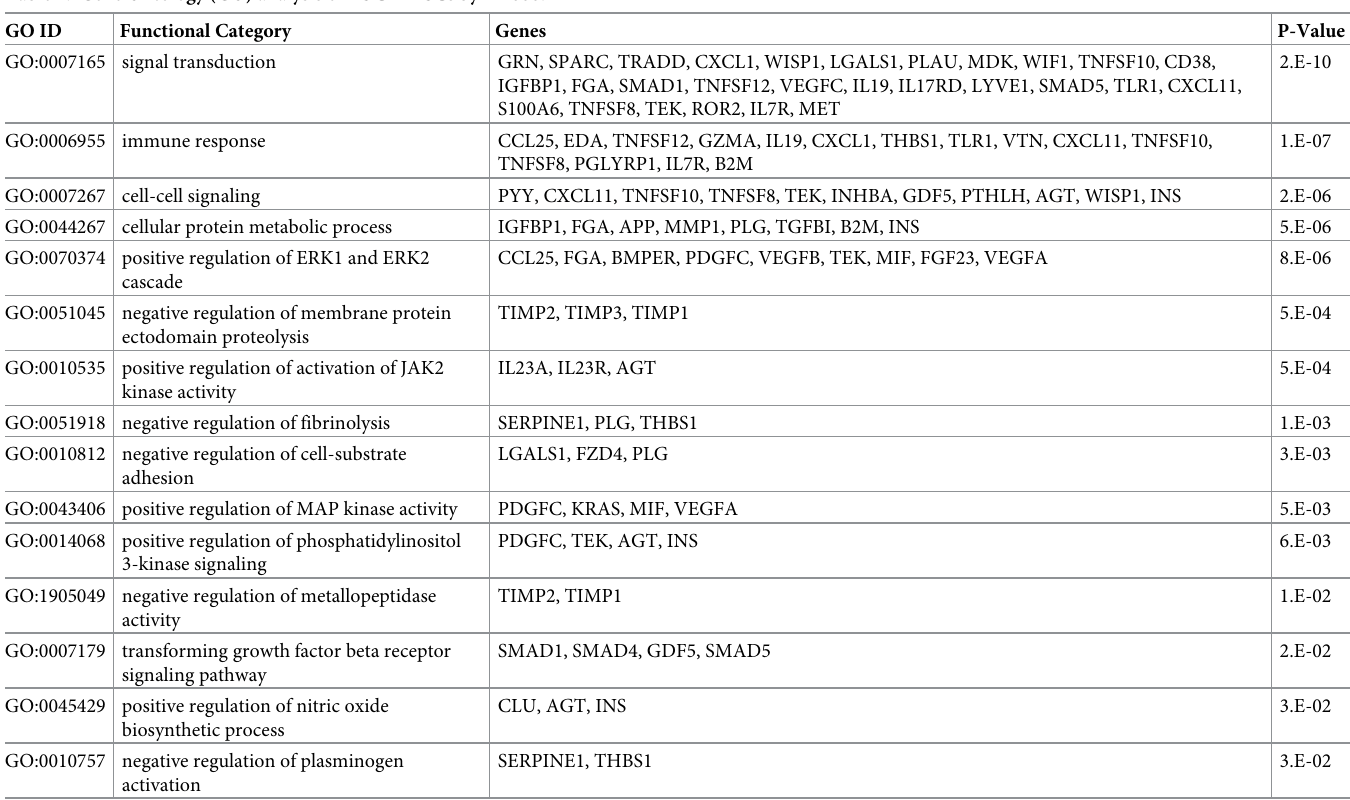
Table 2. Gene Ontology (GO) analysis of hUCB-MSCs by